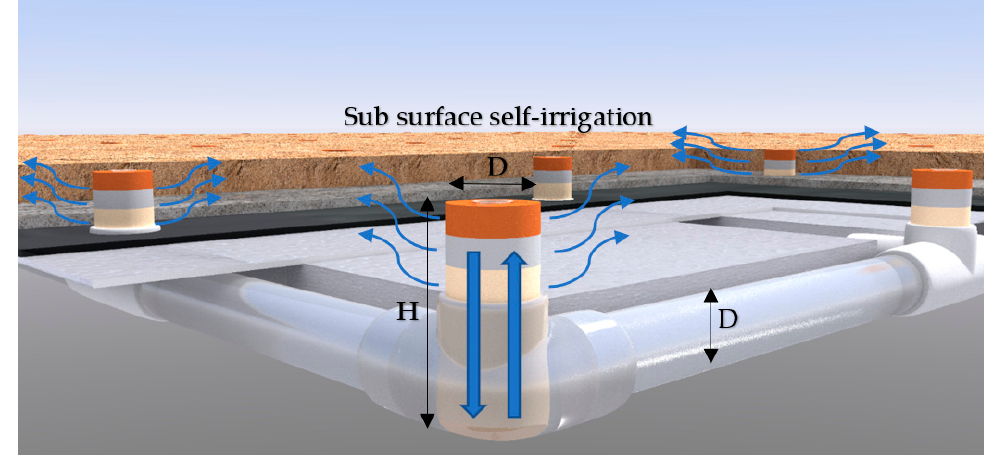
Figure 14. The multilayer filter: each layer has a different infiltration rate. The diameter (D) is equal to the internal diameter of the PVC tube, and the height (H) is equal to the total height of the green roof (from the roof surface to the top of the soil layer).